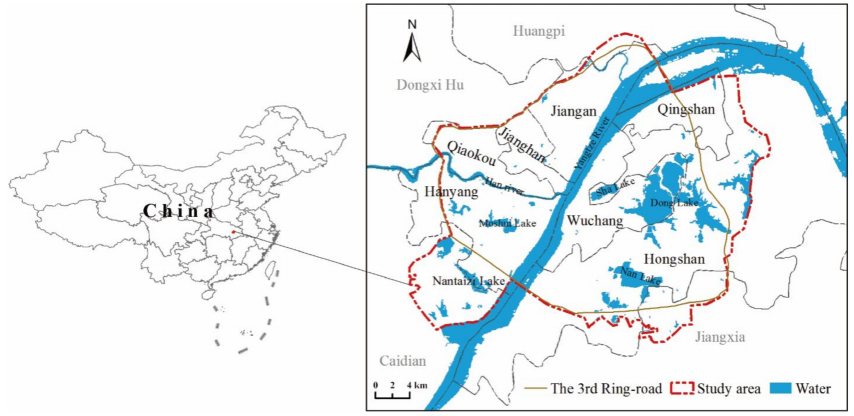
Figure 1. The location of the study area.